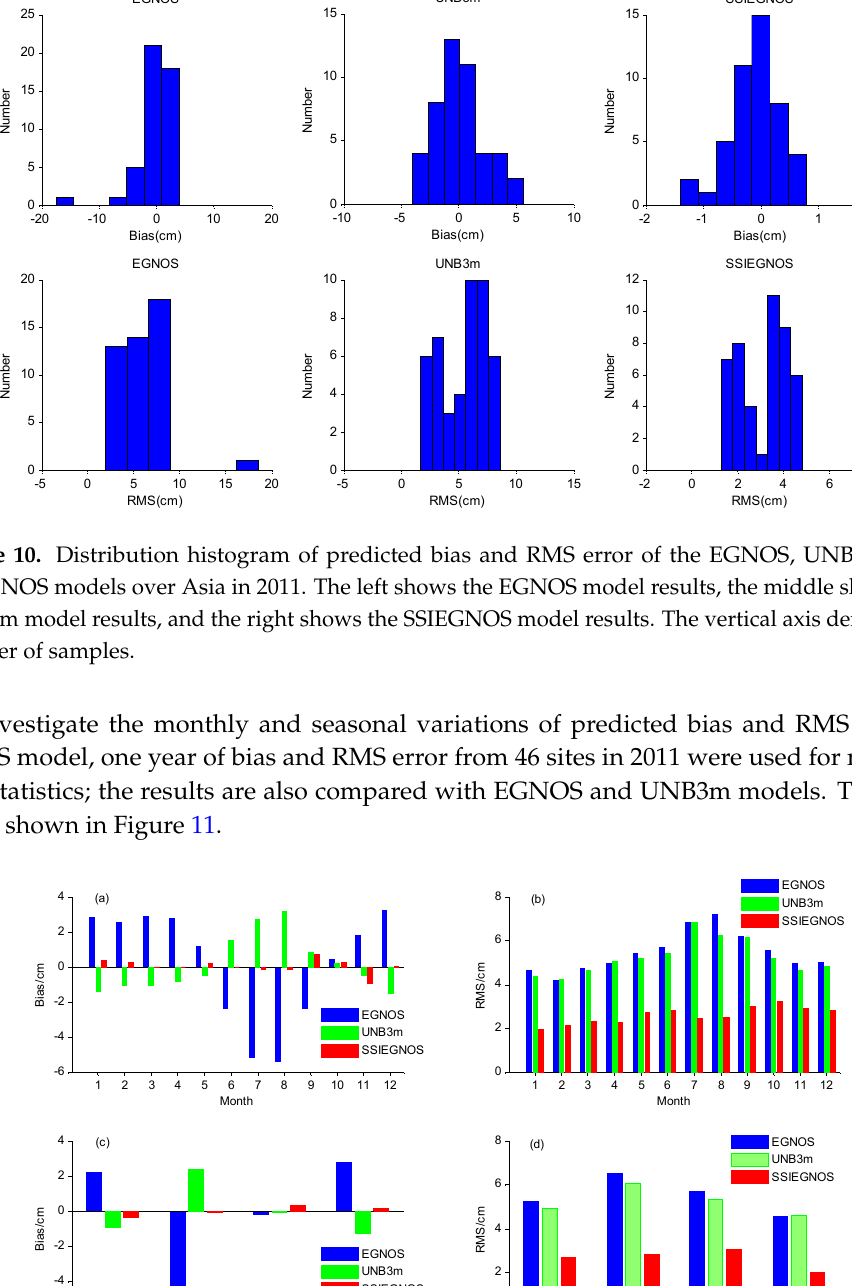
Figure 11. ( a , b ) and ( c , d ) show the monthly and seasonal variations of predicted bias and RMS error in 2011 over Asia using the EGNOS, UNB3m, and SSIEGNOS models, respectively. The blue color denotes the EGNOS model, the green color denotes the UNB3m model, and the red color denotes the SSIEGNOS model.